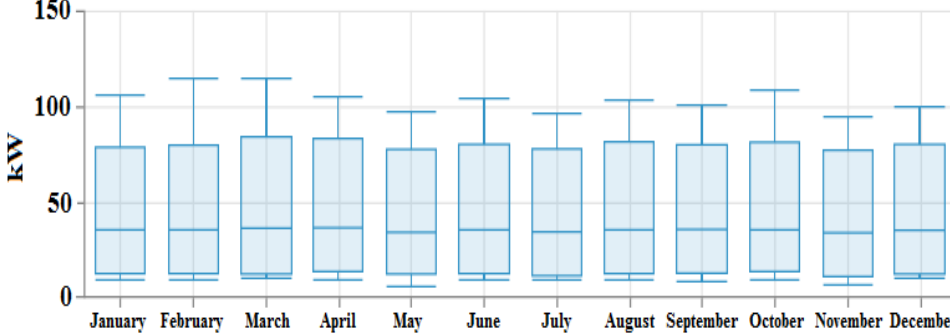
Figure 4. Monthly distribution profile of the load consumption for Yupia [52].